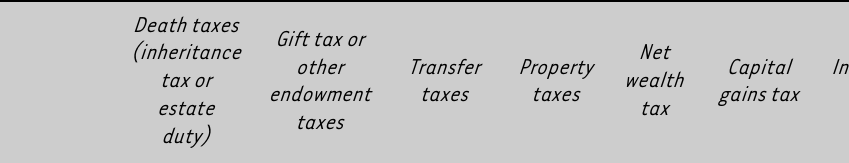
TABLE 1: Visual representation of alternative